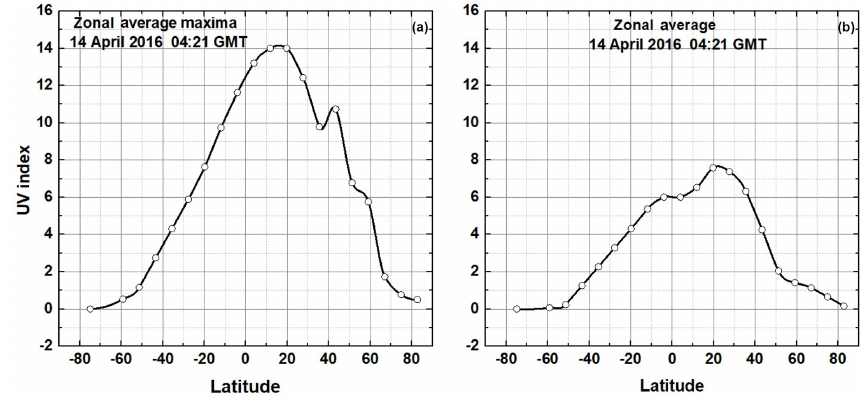
Figure 17. Zonal average of maximum UVI (UVIM a ) and zonal average of mean UVI (UVIA b ) on 14 April 2016 at 04:21GMT from EPIC, including the effect of clouds and haze, as a function of latitude. Both the data points and an Akima spline fit are